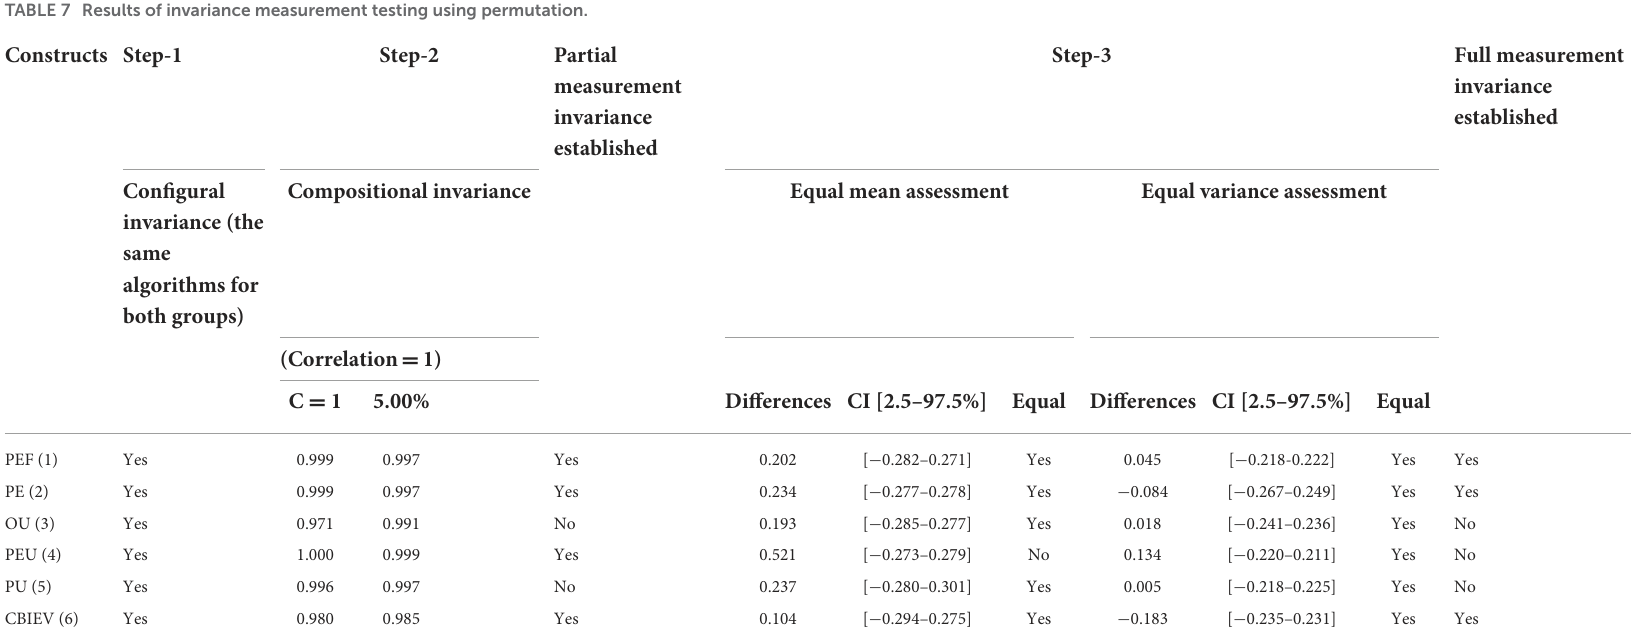
TABLE 7 Results of invariance measurement testing using